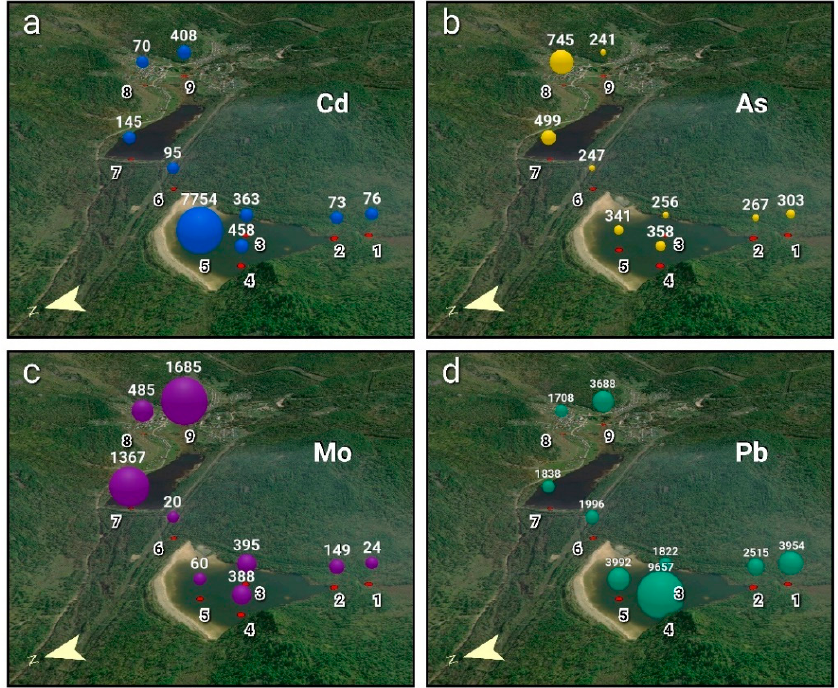
Figure 5. Hydrochemical anomalies of Cd ( a ), As ( b ), Mo ( c ), and Pb ( d ) in samples of surface and ground waters in the area of the Shakhtama tailing dump. Numerals indicate the excess clark ratio for river waters [27].